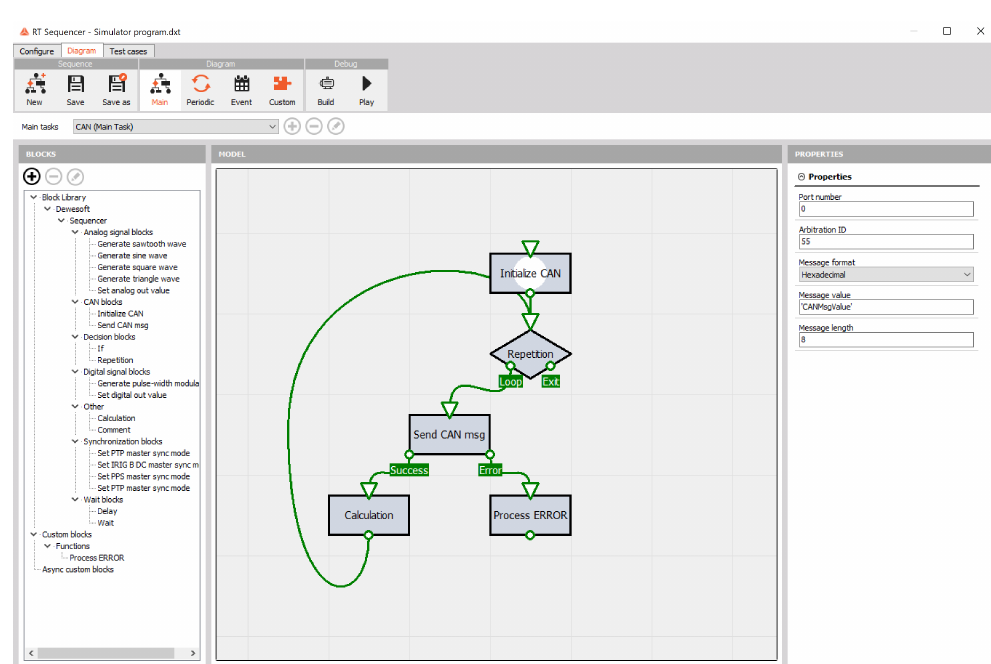
Figure 15. Domain expert model for a CAN